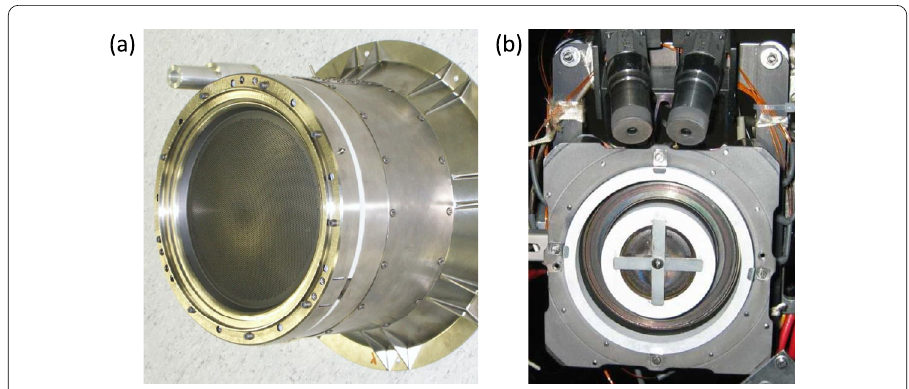
Figure 10 Images of a RIT-22 ( a ) and the SPT-100D before the tests ( b )